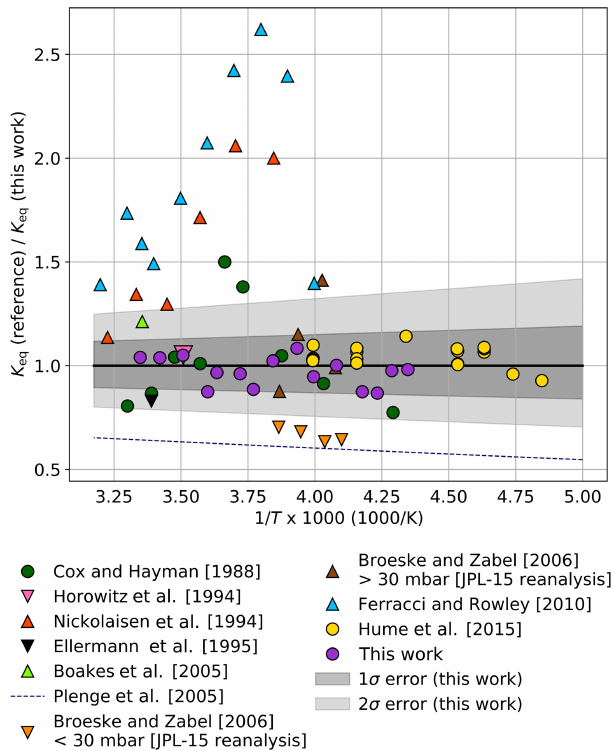
Figure 5. Ratio of K eq values from prior laboratory studies to K eq determined in this work ( K eq = 2 . 16 × 10 − 27 e ( 8527K /T) cm 3 molecule − 1 ) as a function of 1000 /T . Circles indicate studies in which K eq was measured with UV spectroscopy of equilibrium mixtures, while triangles indicate works in which K eq was determined from individual reaction kinetic rates. For clarity, data from this work are plotted as 3K averages (purple circles) of the full data set shown in Fig. 3. Dark gray shading encompasses the total estimated 1 σ error from this study and light shading encompasses the 2 σ